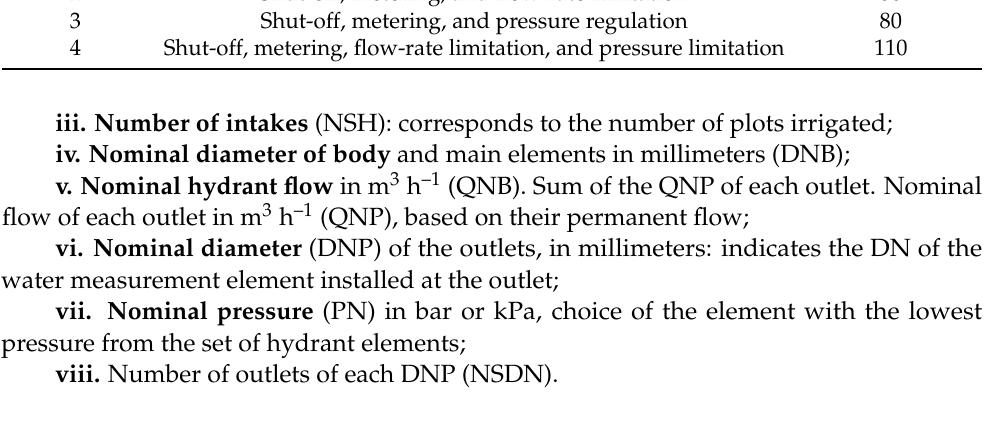
Table 1. Hydrant functions and corresponding admissible head loss according to EN14267 (2004).